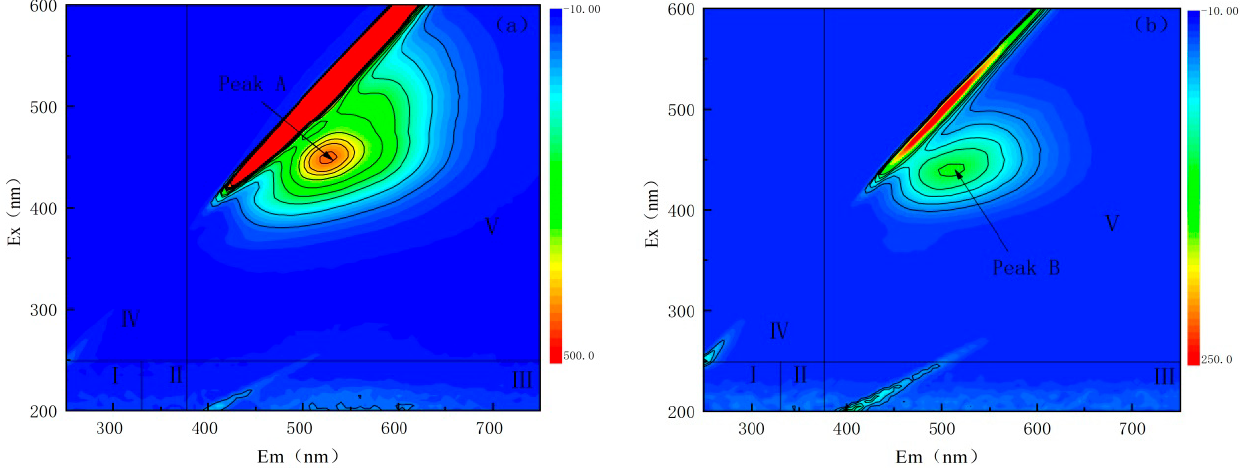
Figure 8. 3D-excitation emission matrix fluorescence spectroscopy of ( a ) input pharmaceutical wastewater and ( b ) treated pharmaceutical wastewater.